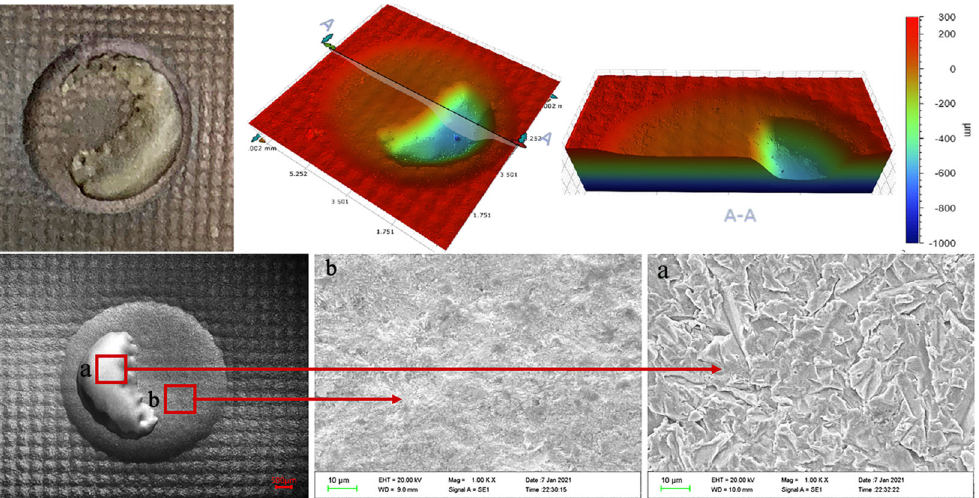
Figure 9. Erosion topography of micro − dimple texture coating. ( a ) morphology of substrate. ( b ) morphology of coating erosion.